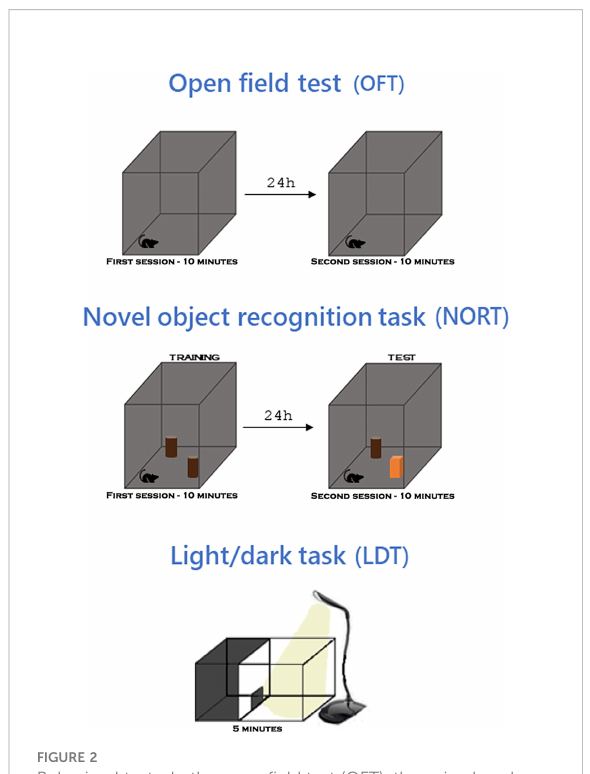
FIGURE 2 Behavioral tests. In the open fi eld test (OFT), the animal explores the apparatus for 10 minutes and 24 hours later explores again. In the novel object recognition task (NORT), performed in the same apparatus as the OFT, the animal explores two identical objects for 10 minutes and 24h later it explores them again, one of the objects being replaced by a different one. In the light/dark task (LDT), the animal explores an apparatus with two compartments, one dark and one light, for 5 minutes. For more details read section Materials and methods on Cognitive and behavioral analysis